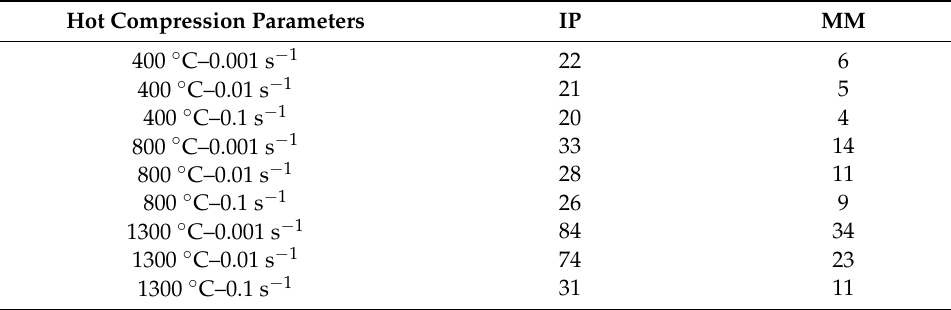
Table 3. Normalized activation volume ( V /b 3 ) of IP and MM